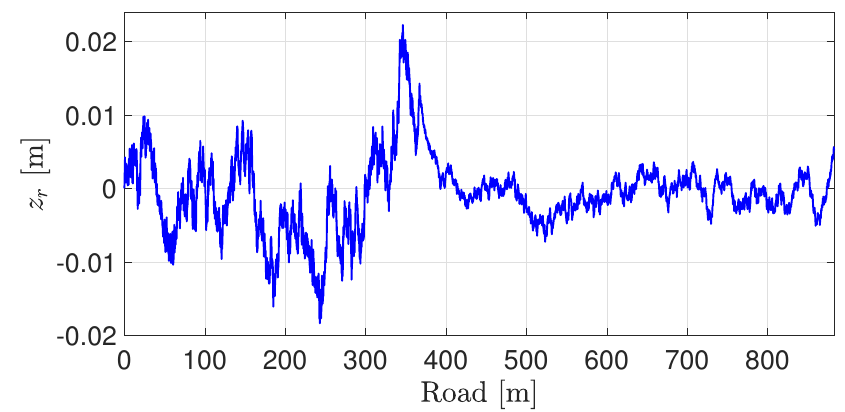
Figure 27. Resulting road input at the front right corner.